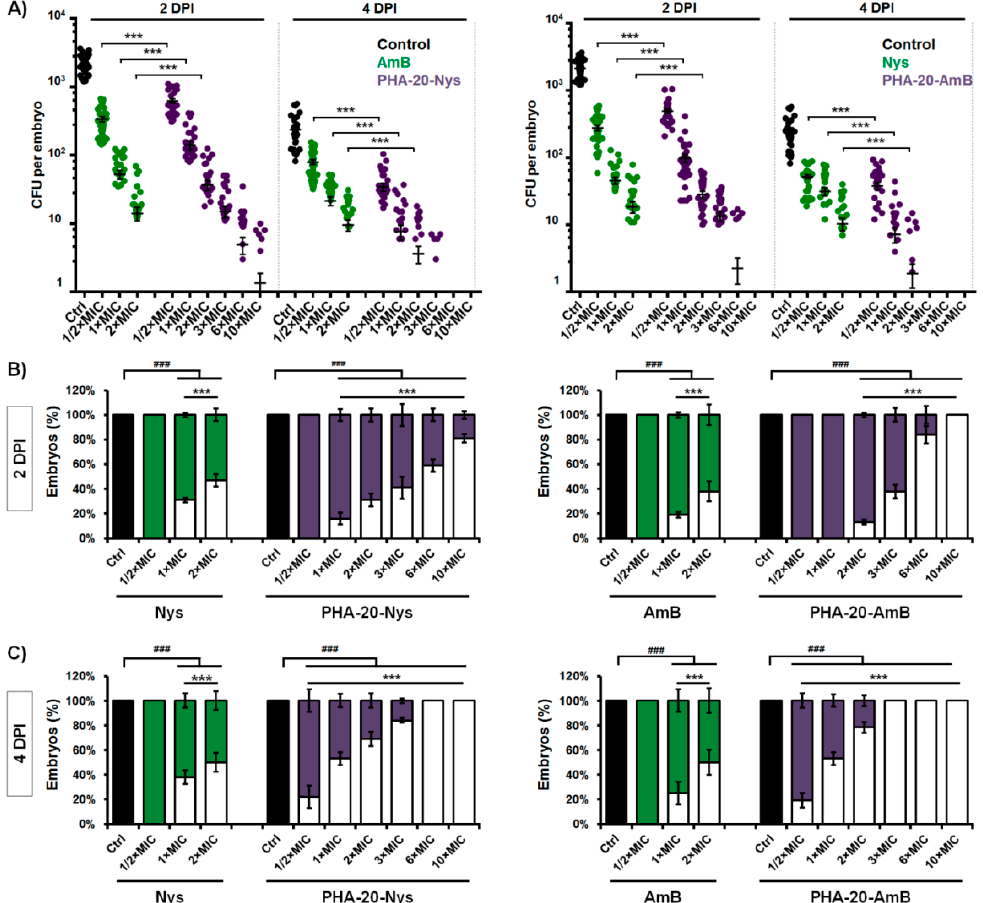
Figure 6. The polyene-loaded microspheres are more effective than the free polyenes in eradication of C. albicans infection. The dose- and time-dependent effect of the free polyenes and the polyene- loaded microspheres on the fungal burden ( A ) and the infection eradication ( B , C ) in the zebrafish infection model of disseminated candidiasis are shown. A) Fungal burden at 2 and 4 dpi is presented as C. albicans CFU per embryo, with each dot representing an individual fish ( n = 32). The mean CFUs ± SD are shown. ( B , C ) Embryos with totally eliminated Candida (no CFU) are shown with empty bars, while those where the infection was detected are shown with solid bars. The presented data are a compilation of four independent experiments using eight embryos for each group ( n = 32). Statistically significant differences between untreated and treated groups were determined using a Student’s t -test (### p < 0.001) and between free drug-treated and PHA/drug-treated groups using χ 2 test (*** p <